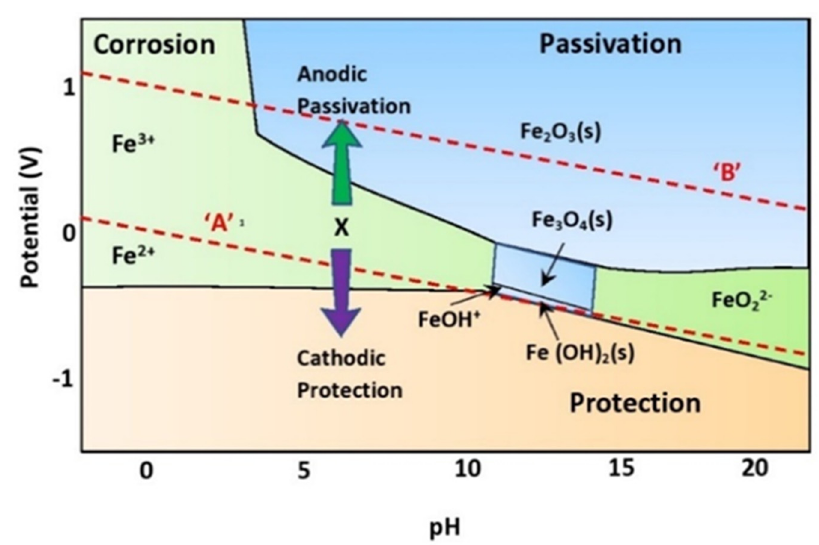
Figure 1. Pourbaix diagram for metals.